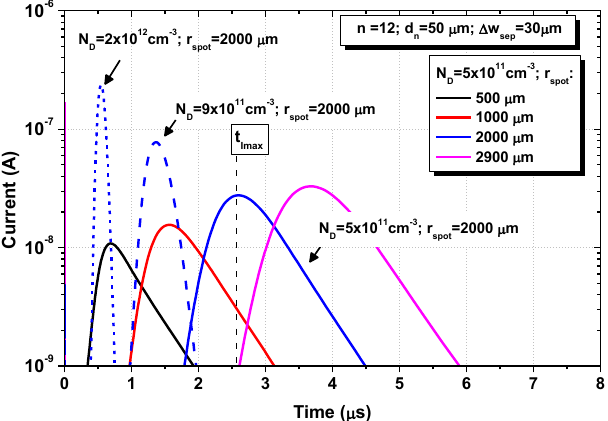
Figure 7. Transient response of the anode current for various TDD structures to 150 eV X-rays for several illumination spot positions r spot and a spot width w spot = 0.1 µm.